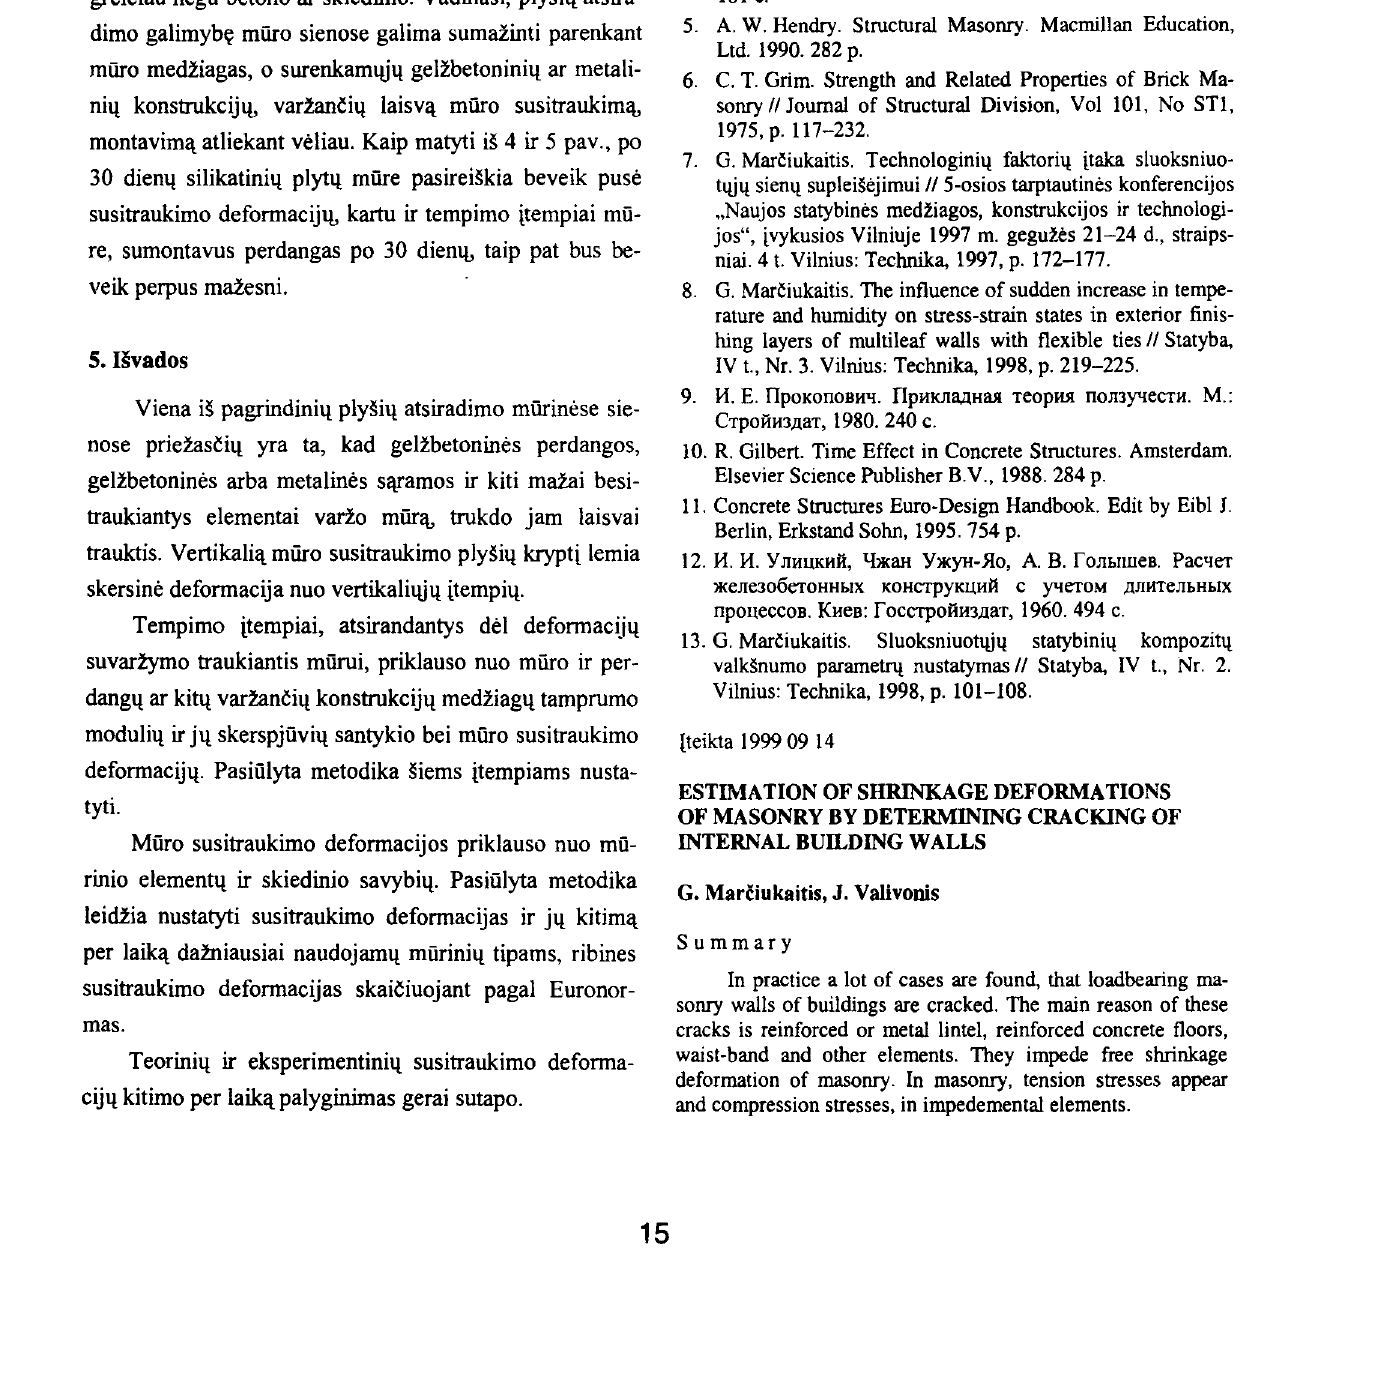
Fig 5. Comparison of theoretical ( 1) and experimental (2) results of silicale brick masonry shrinkage change in time Atlikti tyrimai rodo, kad muro susitraukimas vyksta grei~iau negu betono ar skiedinio. Vadinasi, ply~itt atsira dimo galimyb~ miiro sienose galima sumaiinti parenkant miiro medziagas, o surenkamqjq gelzbetoninitt ar metali niq konstrukcij4, varzan~iq laisv~t miiro susitraukim<l, montavim~t atliekant veliau. Kaip matyti is 4 ir 5 pav., po 30 dientt silikatiniq plyttt miire pasireiskia beveik puse susitraukimo deformacij4, kartu ir tempimo itempiai mu re, sumontavus perdangas po 30 dien4, taip pat bus be veik perpus